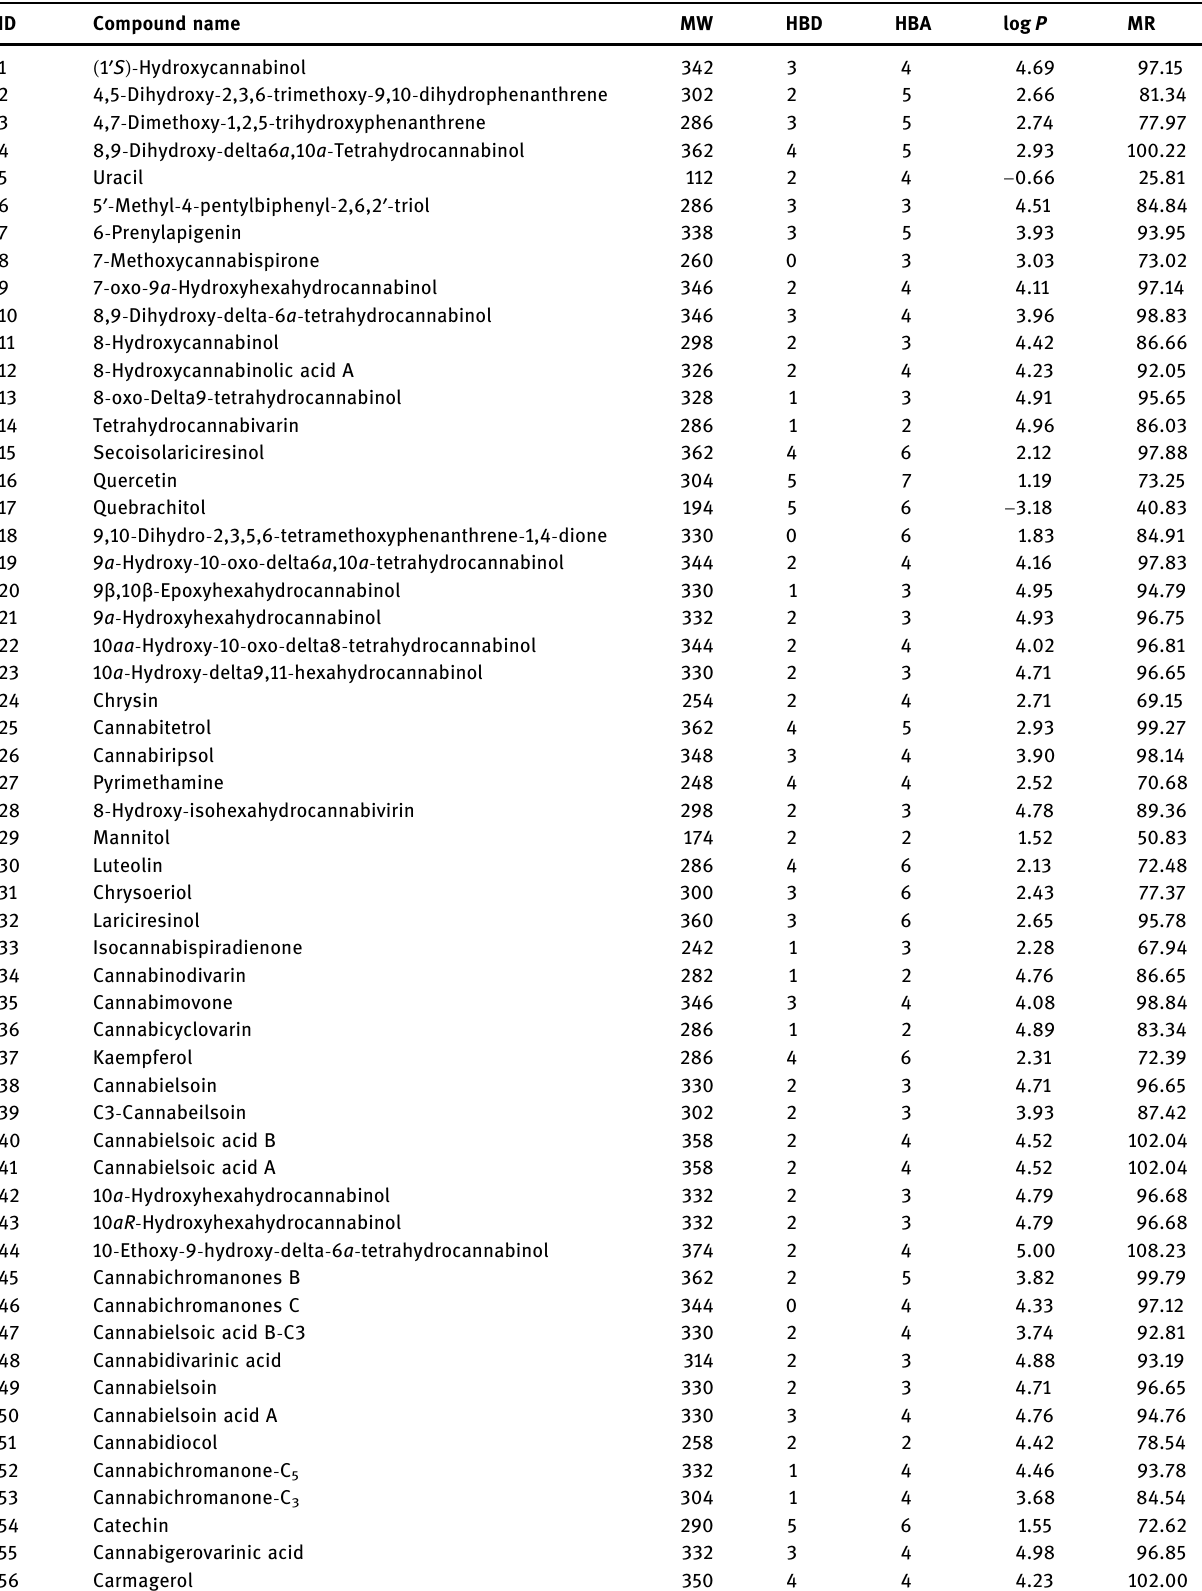
Table 1: List of compounds with drug - like properties satisfying with Lipinski ’ s